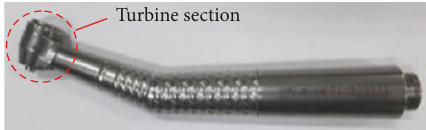
Figure 1: Air turbine handpiece.